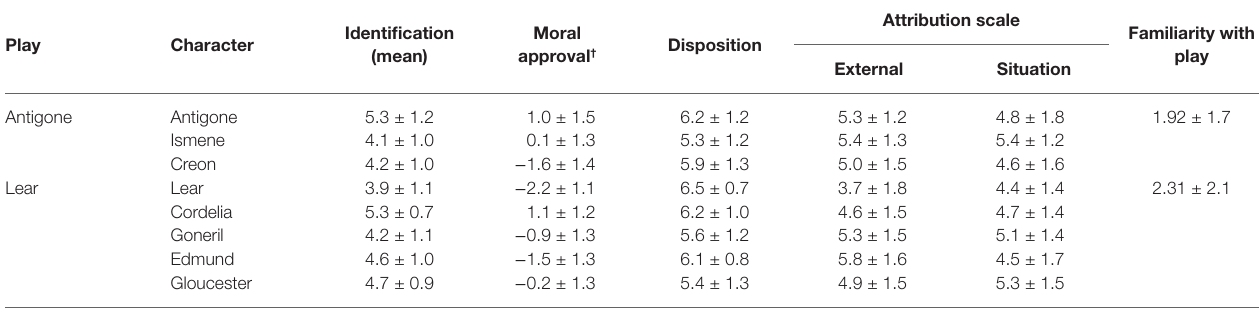
TABLE 2 | Descriptives for conventional characterisation * performance.